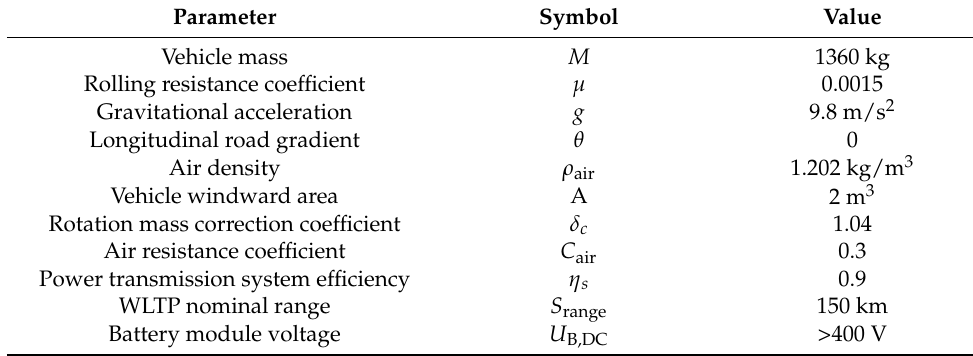
Table 2. Parameters of the